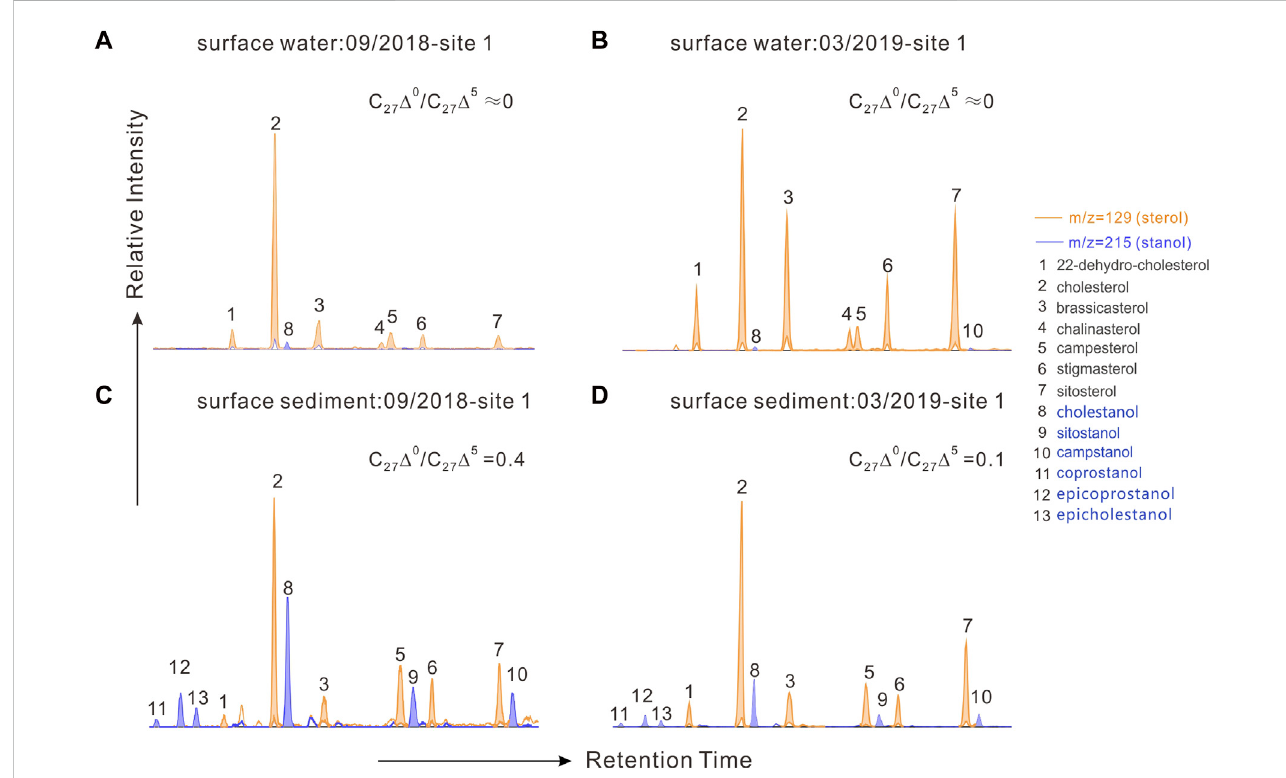
FIGURE 4 Masschromatogramsofm/z129+m/z215showingthedistributionsofsterolsandstanolsinparticulateorganicmatterandsedimentaryorganicmatter. (A,C) , samples from site 1 in the cyanobacterial bloom season (09/2018); (B,D) samples from site 1 in the cyanobacterial decay season